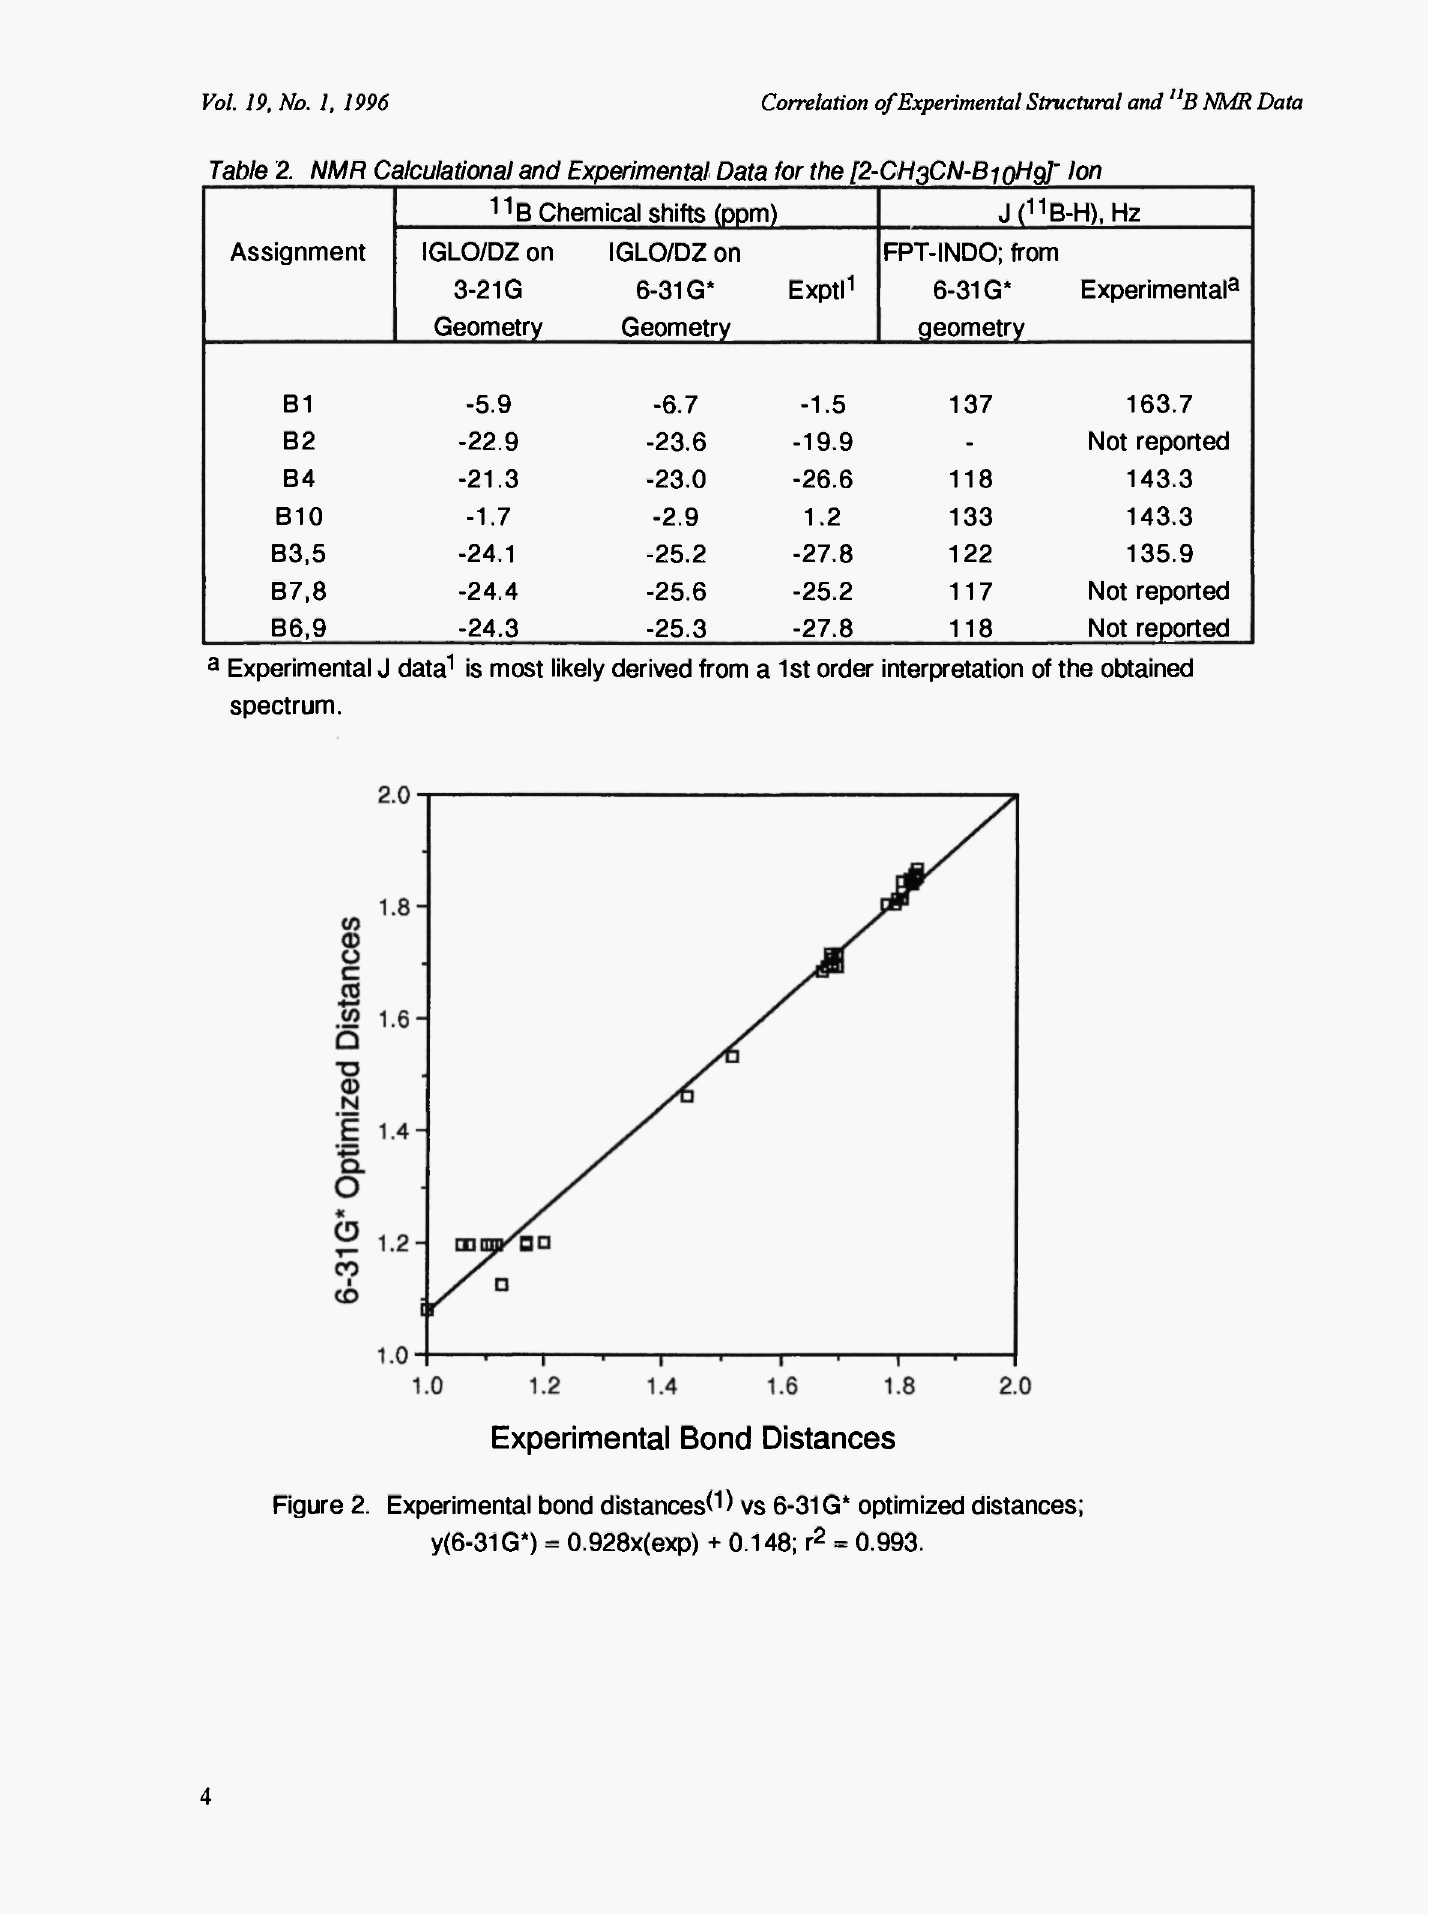
Figure 2. Experimental bond distances* 1 ) vs 6-31G* optimized